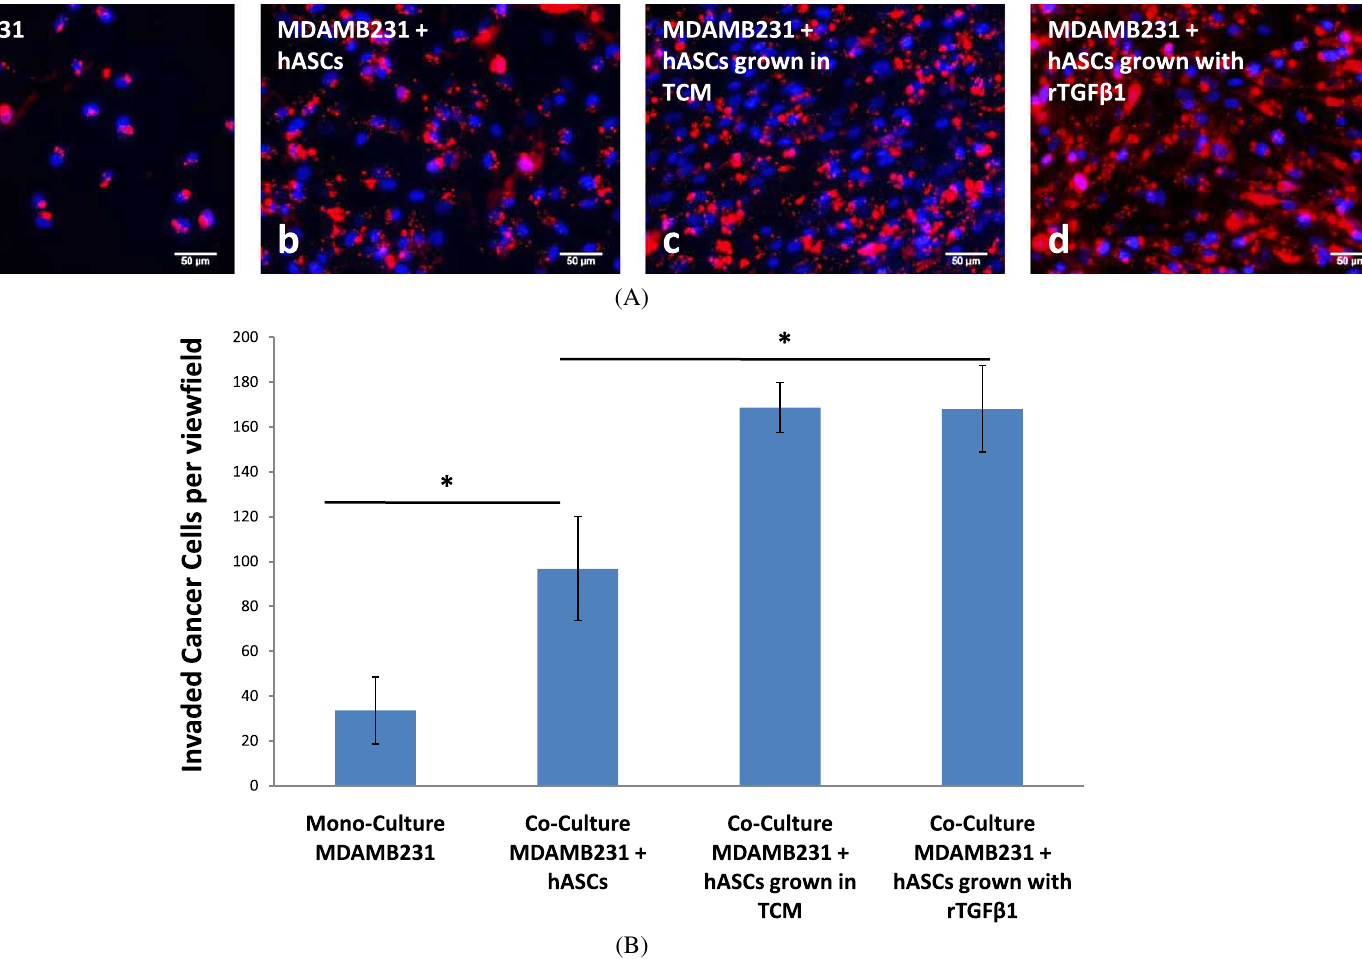
Fig. 6. Tumor conditioned medium activated hASCs and recombinant TGF β 1-treated hASCs promote tumor cell invasion. (A) Fluorescent images of DiI stained MDAMB231 cancer cells (red channel) that invaded into matrigel after 40 h. The nuclei were counterstained with Hoechst (blue). Overlay of red with blue signal shows invaded cancer cells when (a) seeded alone or co-cultured with hASCs previously grown in (b) regular medium, (c) MDAMB231 tumor conditioned medium (TCM) or with (d) 0.2 ng/ml recombinant TGF β 1 for 4 days. Representative pictures of three independent experiments are shown. Scale bar: 50 µm. (B) Invaded DiI/Hoechst-positive MDAMB231 cancer cells were counted in five independent view fields in each group and are shown as mean ± SD with experiments being repeated at least three times. * P < 0 . 001. TCM – tumor conditioned medium; rTGF β 1 – recombinant transforming growth factor beta 1. (The colors are visible in the online version of the